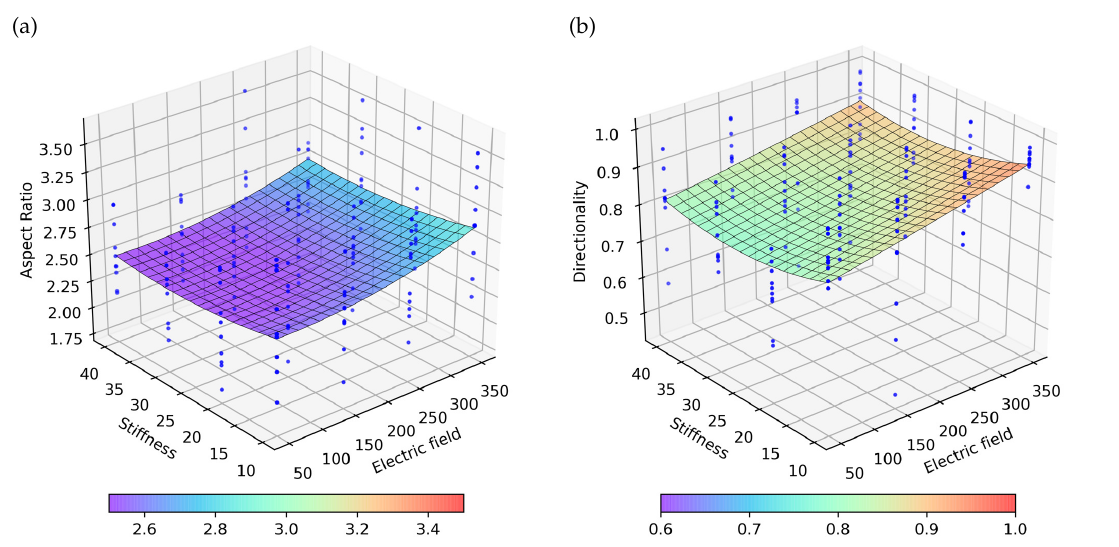
Figure 7. Representation of the obtained numerical results applying a continuous electric field with different intensities in ECM with different stiffnesses. Blue dots represent 10 experiment repetitions, on which the surface with the best fit to the results is represented. ( a ) Aspect ratio for the different combination of stiffness and electric stimulus. ( b ) Directionality for the different combination of stiffness and electric